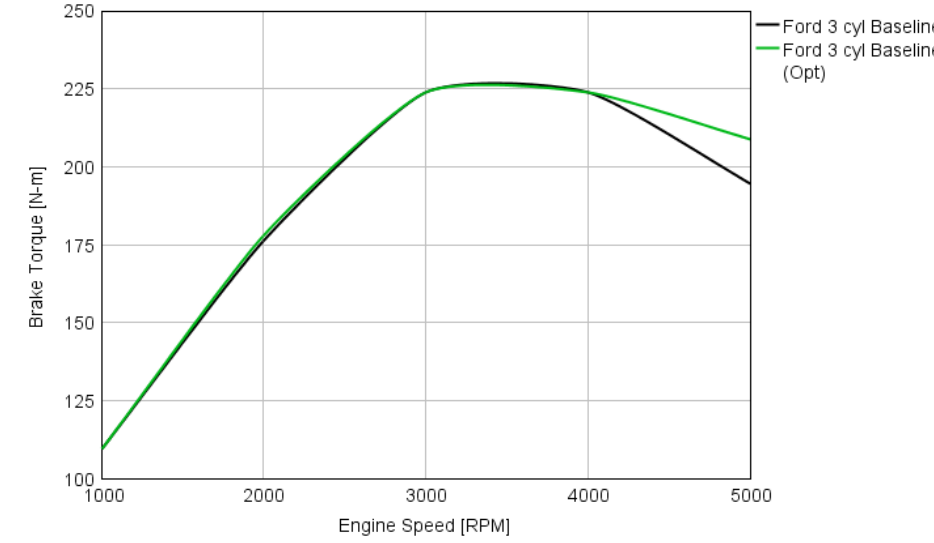
Figure 16. Brake torque versus engine speed for the initial and the optimized baseline models.